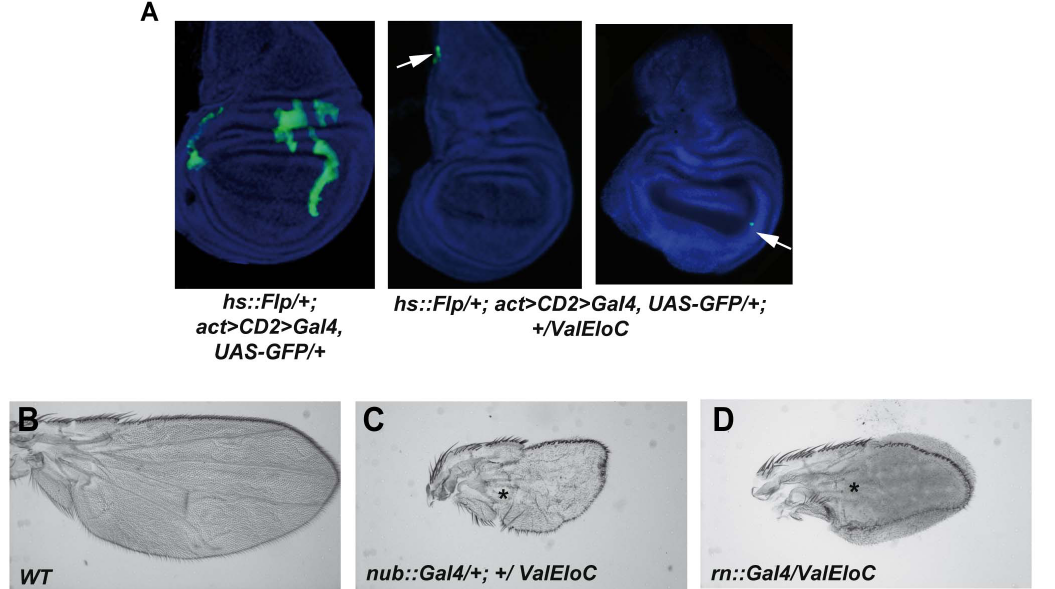
Figure 4. Down-regulation of EloC by RNA interference impairs both cell proliferation and cell differentiation in wing imaginal discs. (A): Clones expressing the ValEloC transgene (GFP + cells, shown by white arrows) are located at the periphery of the disc and are very small compared to control clones. (B, C, D): Wings from pharates in which ValEloC is driven by nub::Gal4 (C) or rn::Gal4 (D), both expressed in the wing pouch [66,67] are small compared to wild-type pharate wings (B) and exhibit severe wing blade defects. By contrast, longitudinal veins (shown by asterisks) are formed in the proximal-most part of the wing blade where nub::Gal4 and rn::Gal4 are not expressed.